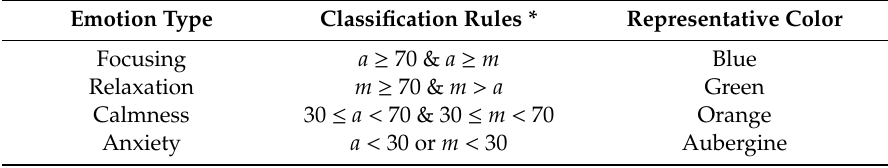
Table 1. Classification of brain wave signals into four types of emotions with representative colors. Emotion Type Classification Rules * Representative Color Focusing a ≥ 70 & a ≥ m Blue Relaxation m ≥ 70 & m > a Green Calmness